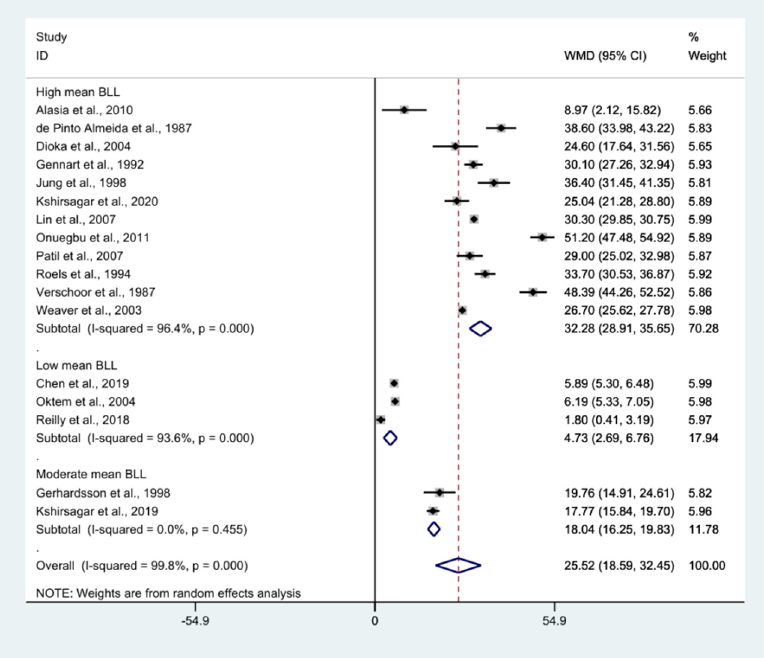
Figure 3. The mean difference in BLL between exposed and non-exposed participants. WMD: Weighted Mean Difference (µg/dL), % Weighted: the impact proportion of each study to the pooled effect, CI: Confidence Interval (µg/dL), Black diamond symbol: point estimate for each study, White diamond symbol: pooled WMD in each subgroup or all groups, Solid line in the middle of the graph at 0: no difference in WMD between the two groups, Dashed line: pooled WMD between the two groups.